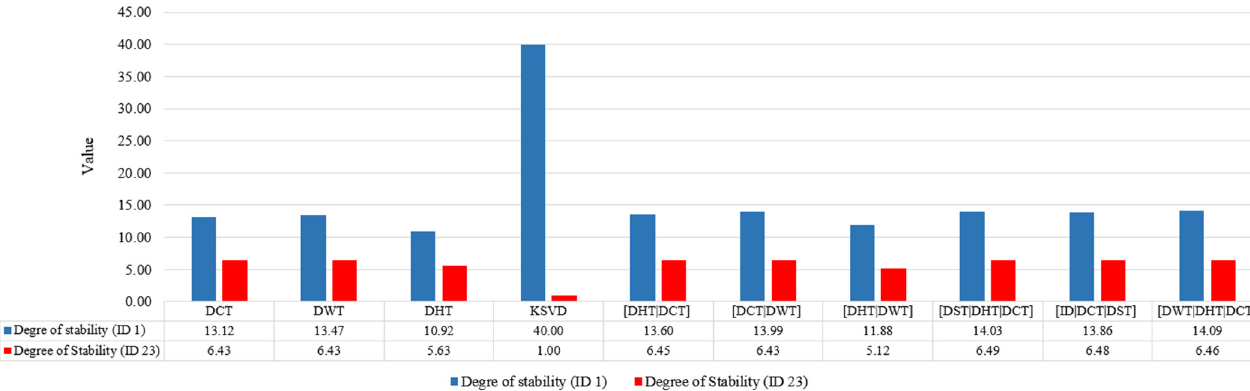
Figure 10. Stability degree of adaptive, single, hybrids with two and three overcomplete dictionary learning.